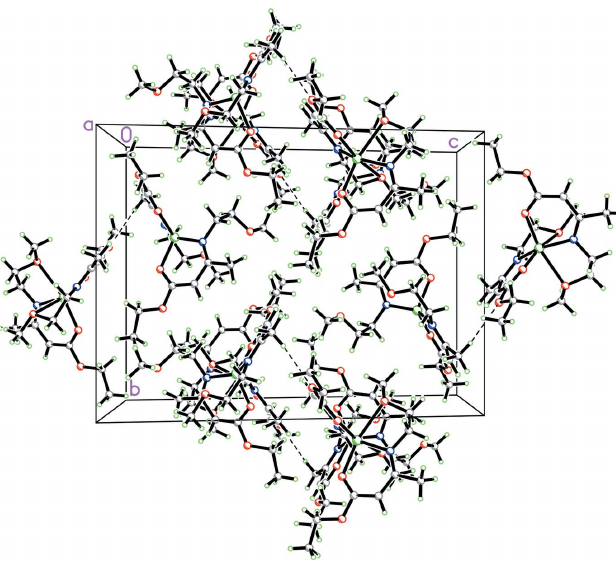
Figure 3 Packing diagram for 1 showing both the intra- and intermolecular C— H (cid:3)(cid:3)(cid:3) O interactions.